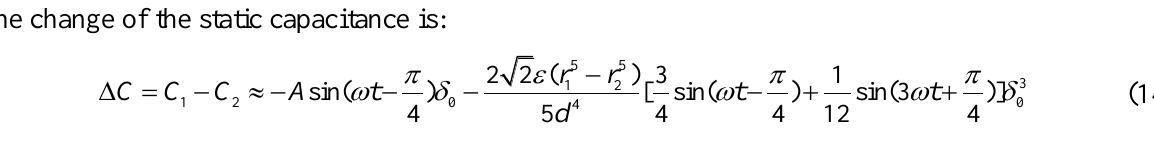
Figure 7. Schematic diagram of the installation error of disc rotor